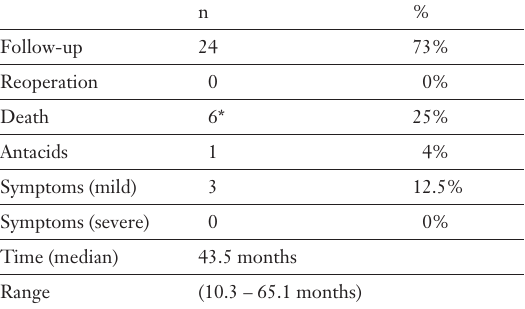
Follow-up of H. pylori treated patients (n = 33).